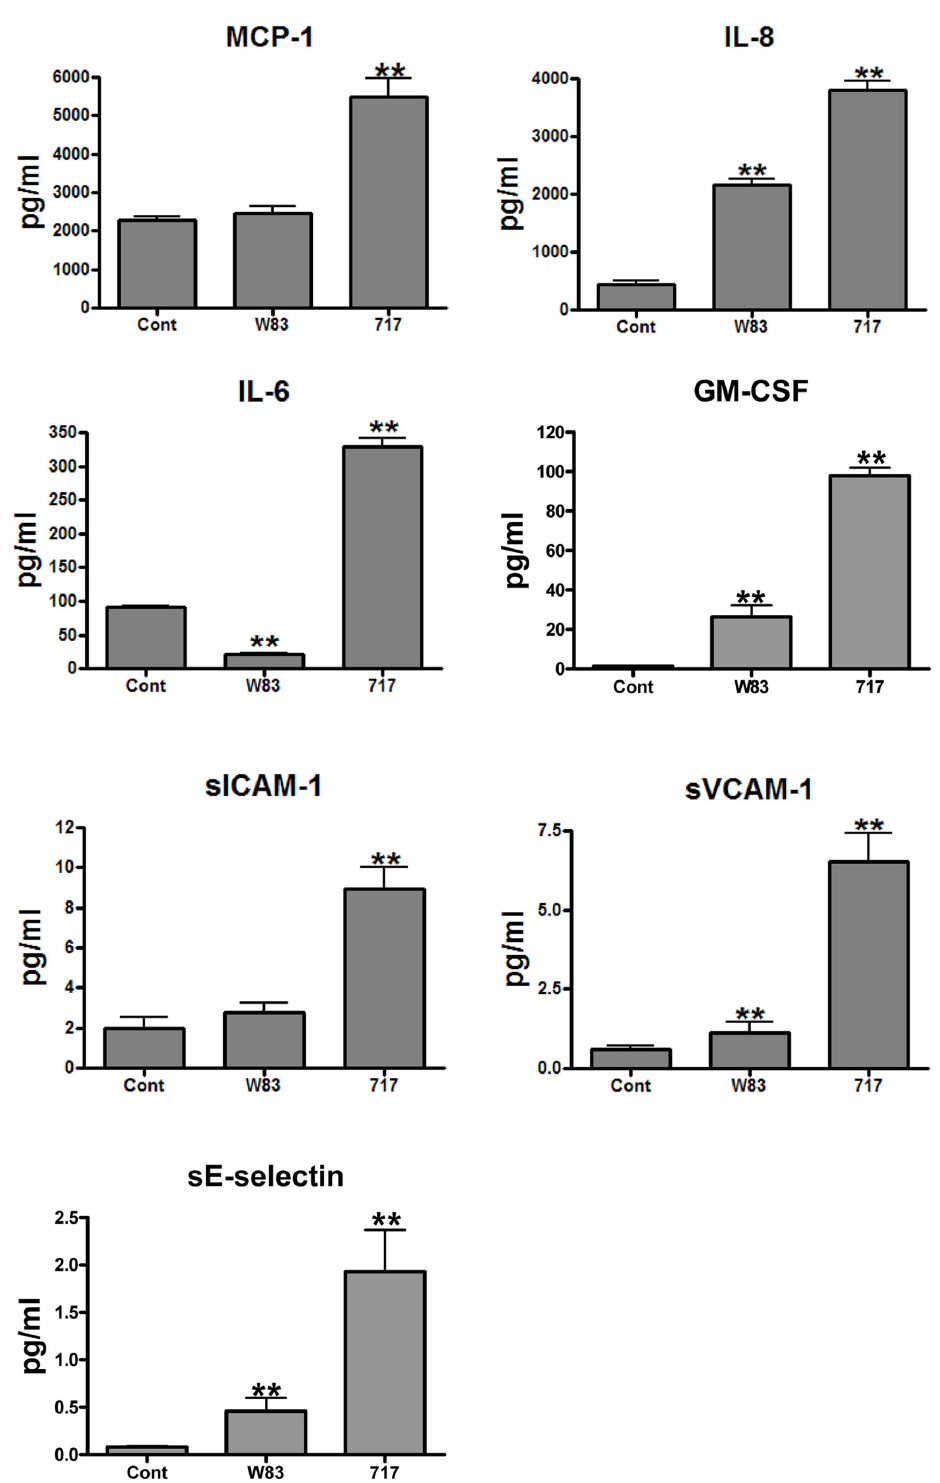
Figure 4. Inflammatory mediator profile of uninfected and P. gingivalis infected HCAEC. HCAEC were infected with 10 7 bacteria (MOI of 100). Cell culture supernatants were collected at 24 hours PI and analyzed with Milliplex detection kits. Values represent the mean ± SD concentration from 3 independent experiments ( n = 3). **Indicates group means that were significantly different by ANOVA followed by Fisher’s multiple comparison test ( P < 0.001).